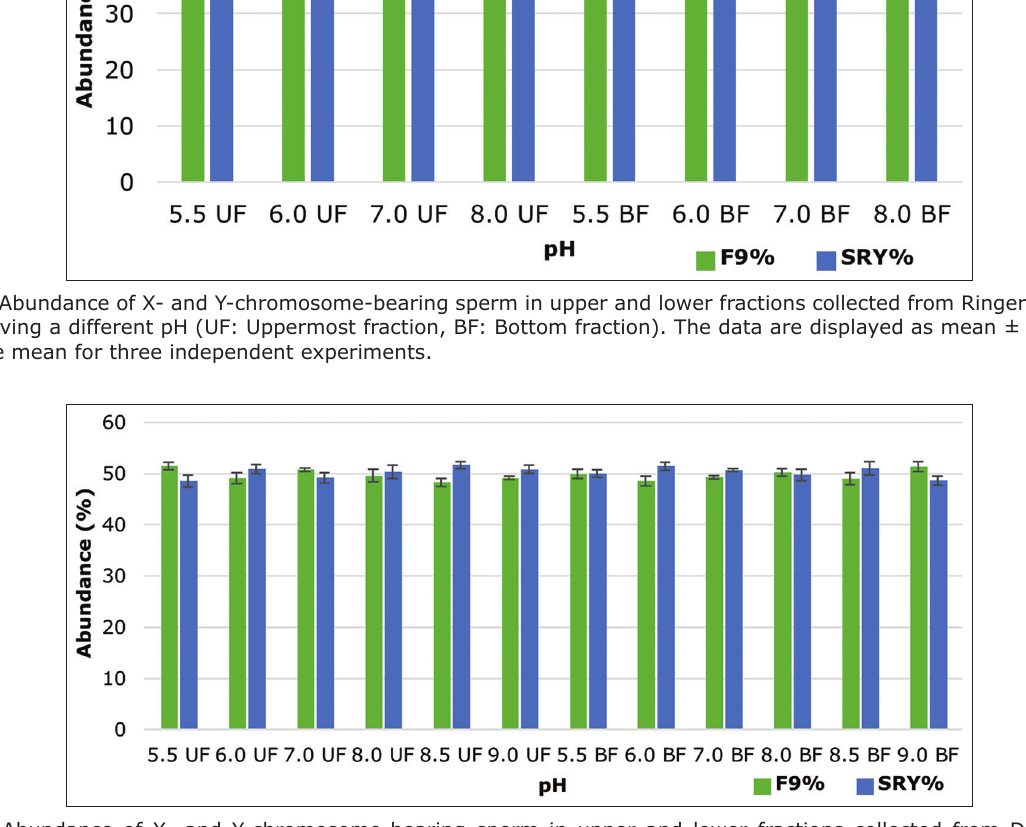
Figure-2: Abundance of X- and Y-chromosome-bearing sperm in upper and lower fractions collected from Dulbecco’s Modified Eagle Medium having a different pH (UF: Uppermost fraction, BF: Bottom fraction). The data are displayed as mean ± standard error of the mean for three independent